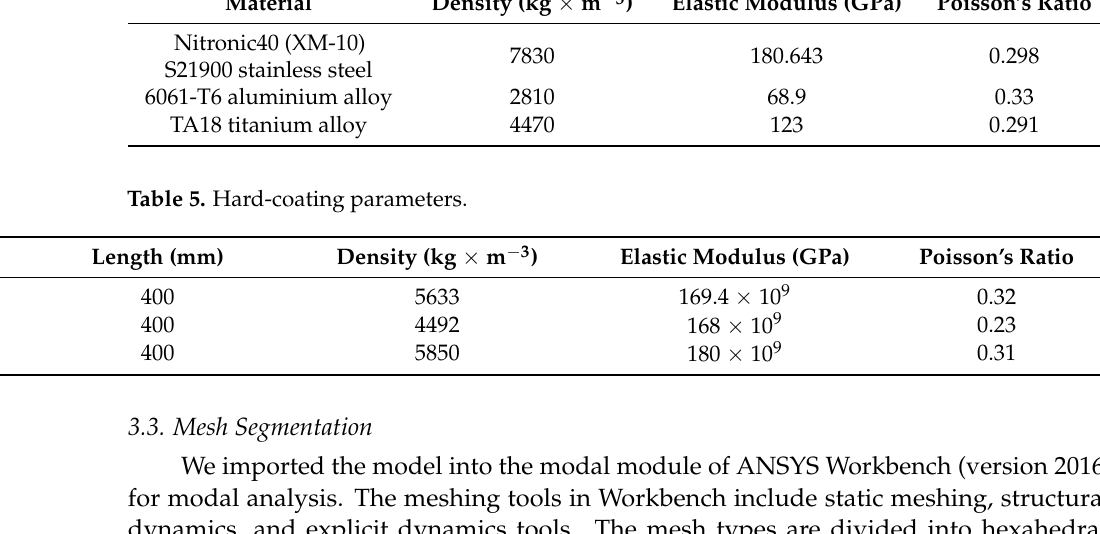
( b ) Figure 4. Model meshing ( a ) without the hard coating and ( b ) with the hard coating. 4. Finite Element Analysis of the Hard-Coated Straight Aviation Hydraulic Pipe 4.1. Modal Analysis of the Hard-Coated Straight Aviation Hydraulic Pipe The effects of the hard-coating material and thickness on the natural frequency of the model and the displacement of the main mode shape were explored. The 3D model of the aeroengine hydraulic pipeline established in SolidWorks was imported into the modal module of ANSYS Workbench. A modal analysis of the straight aviation hydraulic pipe before and after coating was carried out to obtain the first 10 natural frequencies and the displacement of the main mode shape. Several modal vibration diagrams are presented in Figure 5. The results are shown in Tables 6–9. The main mode shape displacement com- parison diagram is shown in Figure 6. First-order.